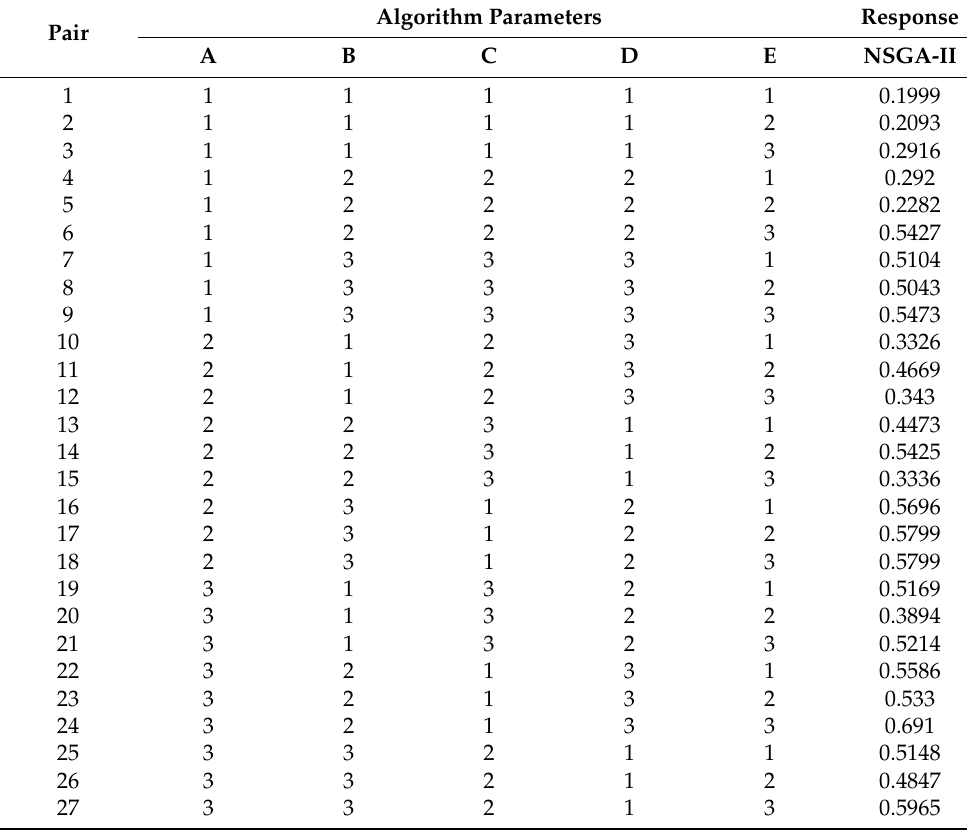
Table A1. Experiment results of L27 Taguchi.